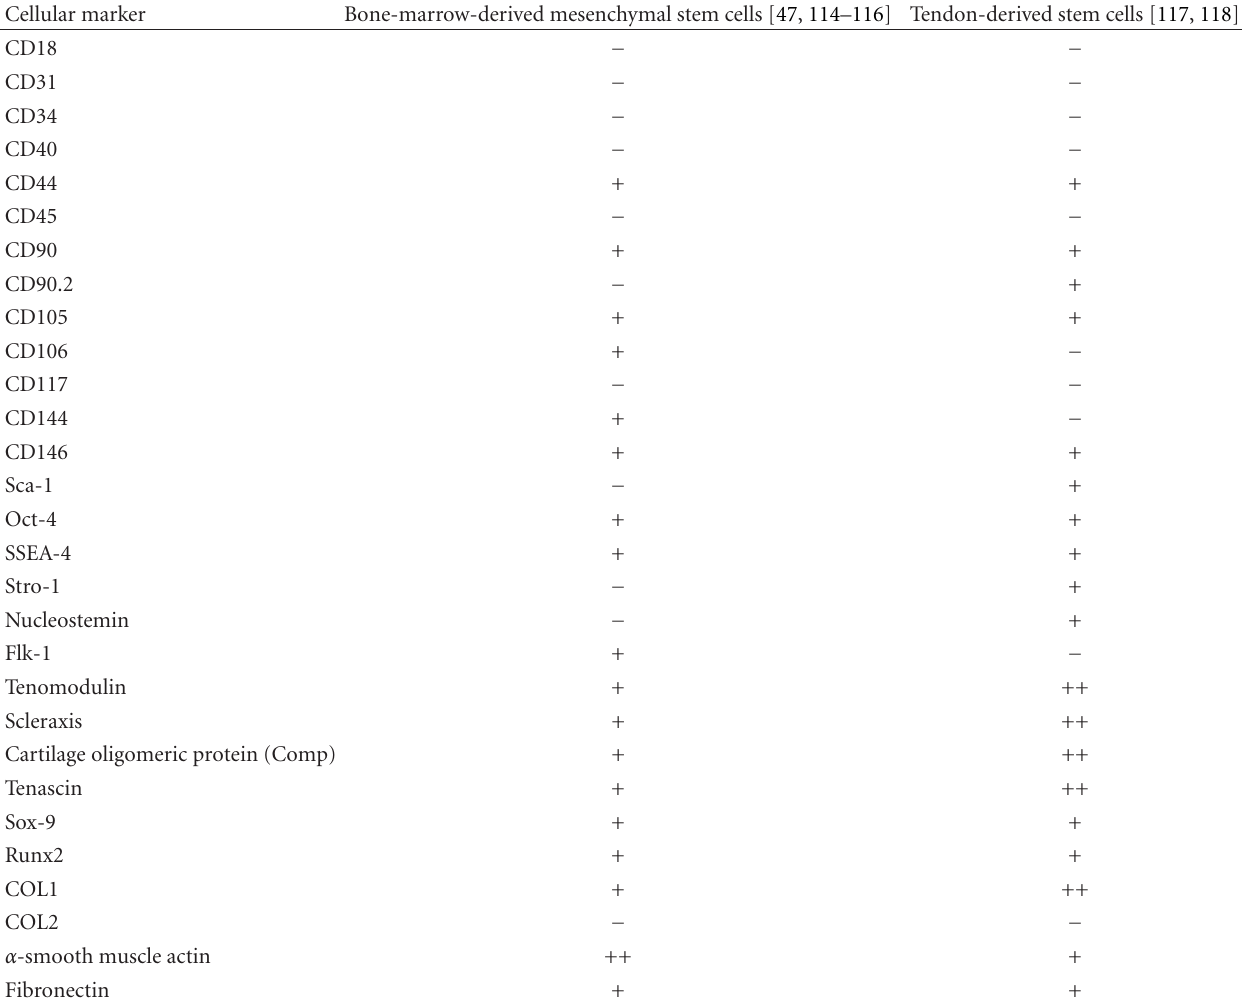
Table 1: Immunohistochemical comparison of MSCs and TDSCs. Cellular